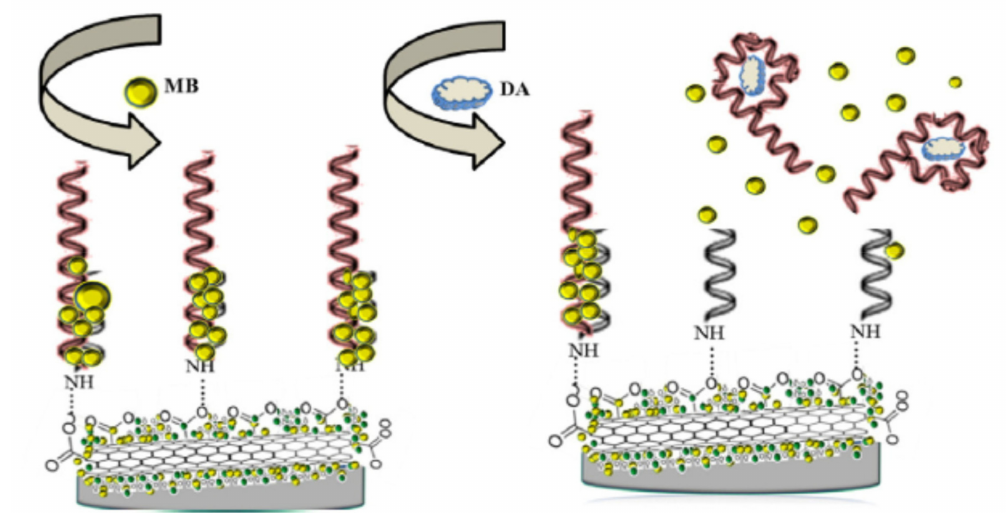
Figure 10. Schematic illustration of the target-induced aptamer displacement format and signal amplification by accumula- tion of redox probes. Reprinted and extracted from reference [38] with permission from